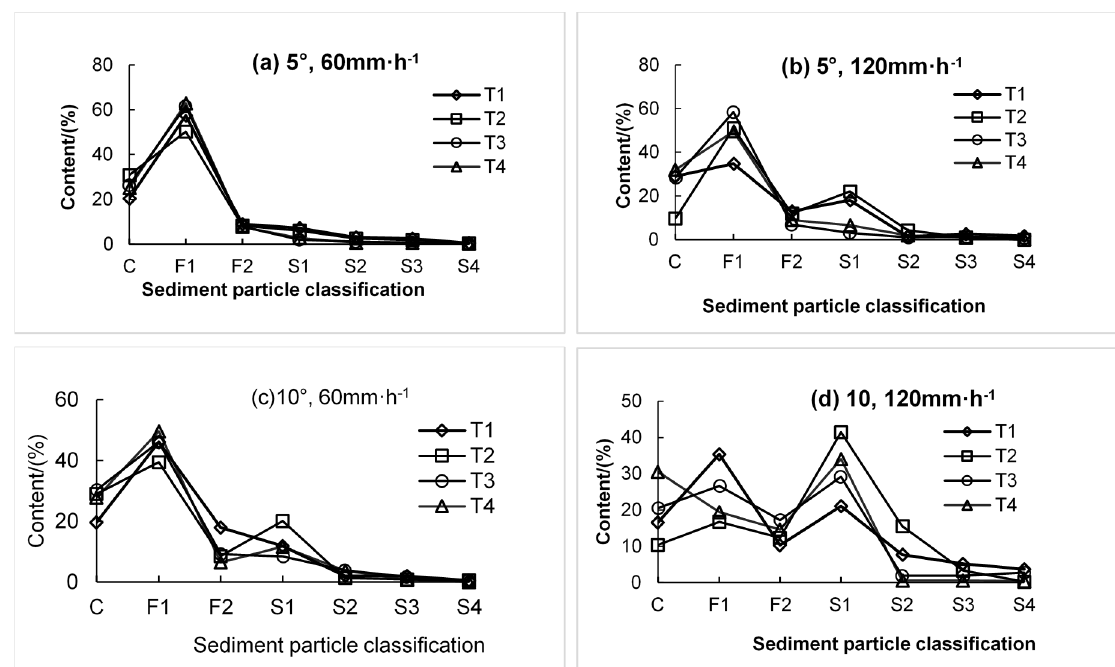
Figure 2. Particle size composition of the erosion sediment. ( a ) Particle size composition of the erosion sediment under a slope of 5° and rainfall intensity of 60 mm·h − 1 ; ( b ) Particle size composition of the erosion sediment under a slope of 5° and rainfall intensity 120 mm·h − 1 ; ( c ) Particle size composition of the erosion sediment under a slope of 10° and rainfall intensity 60 mm·h − 1 ; ( d ) Particle size composition of the erosion sediment under a slope of 10° and rainfall intensity 120 mm·h − 1 . C is clay (<0.002 mm), F1 is fine powder (0.002–0.02 mm), F2 is coarse silt (0.02–0.05 mm), S1 is fine sand (0.05–0.25 mm), S2 is medium sand (0.25–0.5 mm), S3 is coarse sand (0.5–1 mm), and S4 is very coarse sand (1–2 mm).